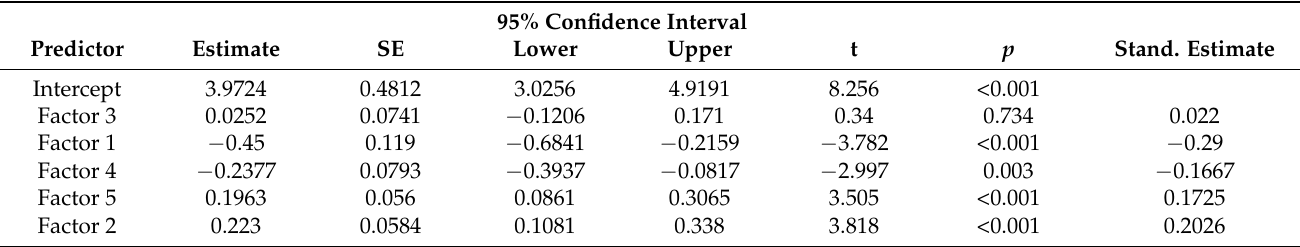
Table 4. Model coefficients of OSHP, POE PJI, PAOS and CF predicting TI. 95% Confidence